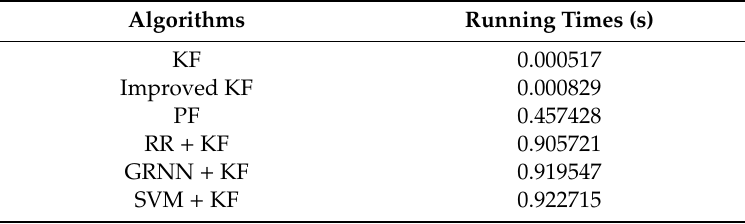
Table 7. Running times of the